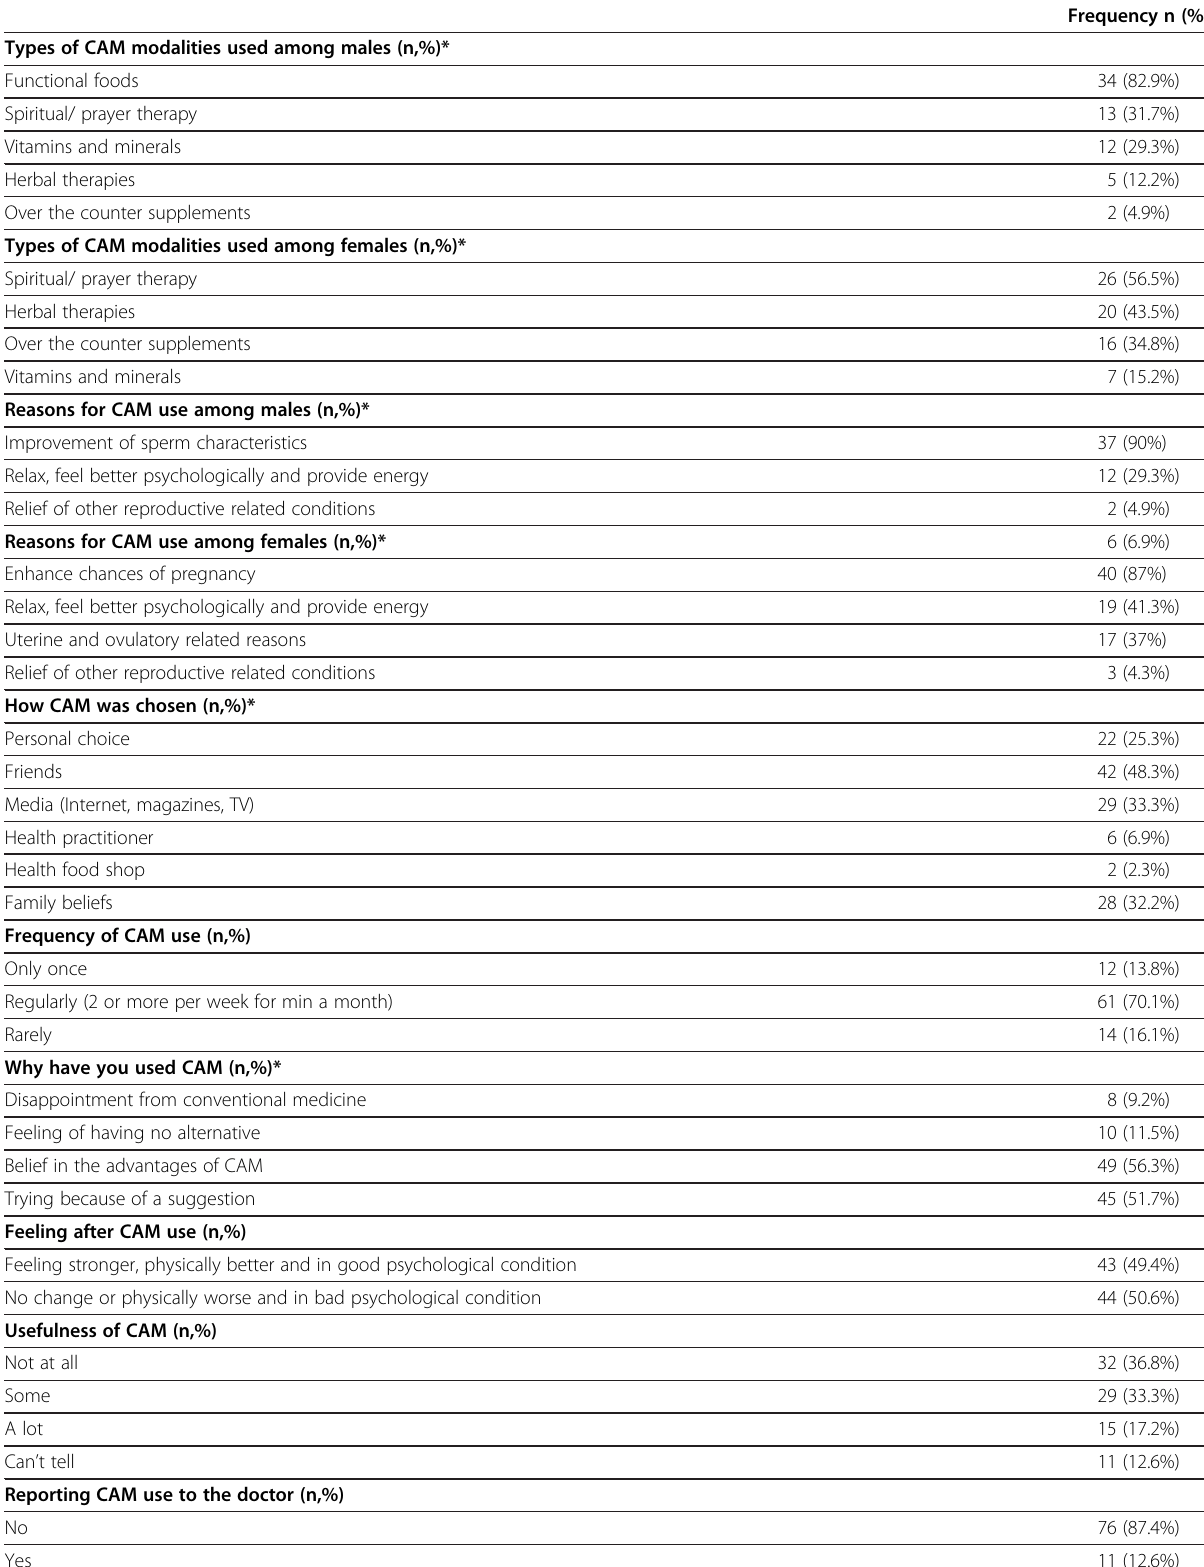
Table 2 Types and modes of CAM use among couples seeking infertility treatment (n = 87)